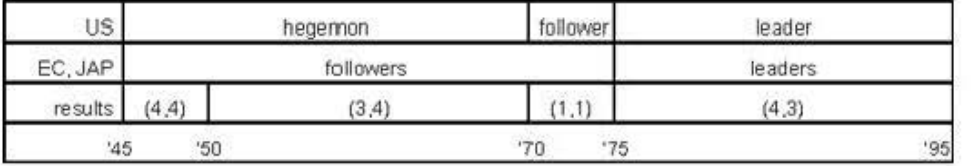
Table 4.6 Equillbrla from Hegemony to Joint leadership : A Model of Postwar Developme